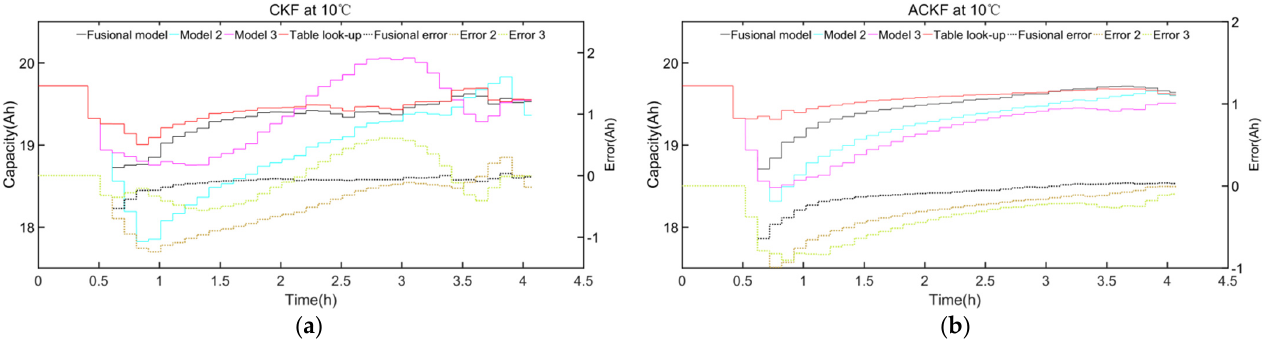
Table 9. RMSE of capacity estimation for NMC battery (Ah).